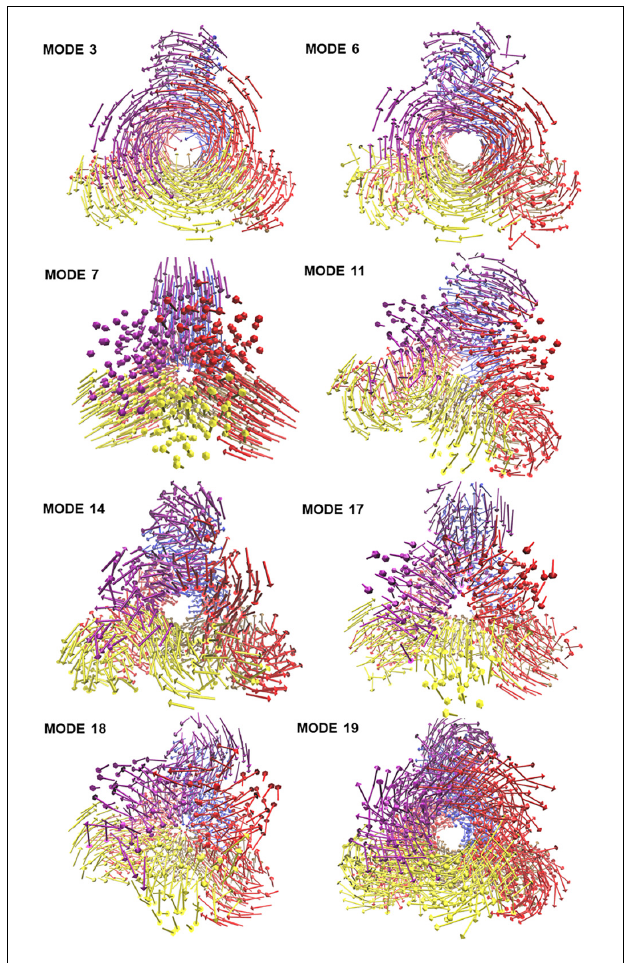
FIGURE 2 | The projection of the eight slowest non-degenerate modes onto the structure of PTPS. Eigenvectors have been projected as a set of arrows that denote the direction of motion of the protein C β atoms. The 3D structure is PTPS P. falciparum (PDB ID: 1Y13). Each of the protein chains is colored differently for illustration